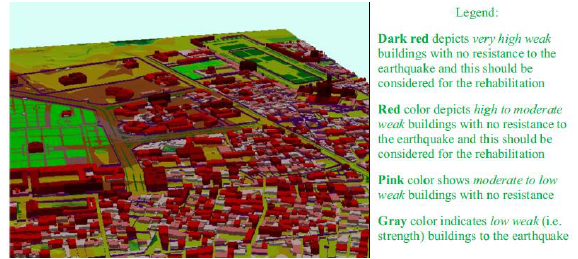
Figure 3. Classification of building damage index